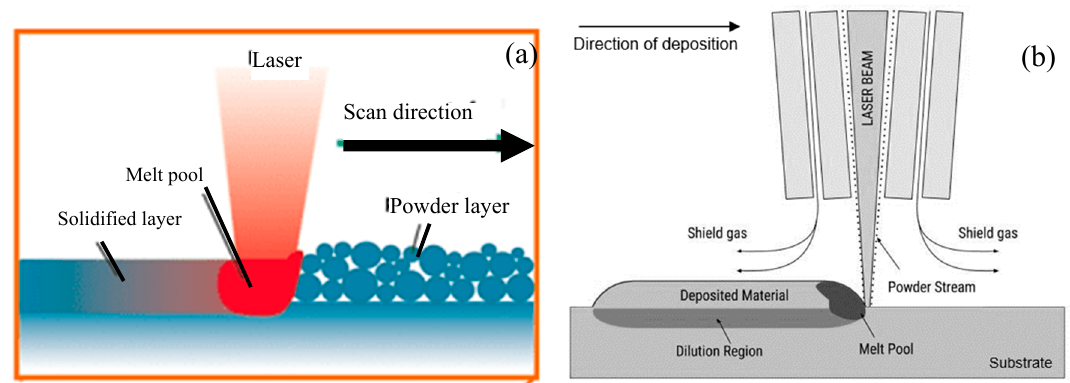
Figure 1. Schematic of ( a ) powder bed fusion, ( b ) powder-based directed energy deposition processes Figure1. Schematicof( a )powderbedfusion, ( b [4].